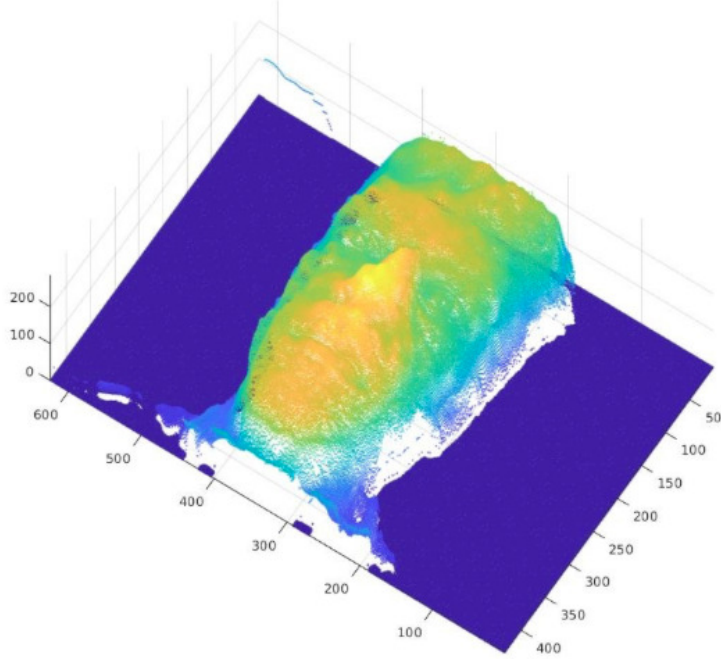
Figure 11. Resulting depth map after roughness restriction [35] and cost volume refinement